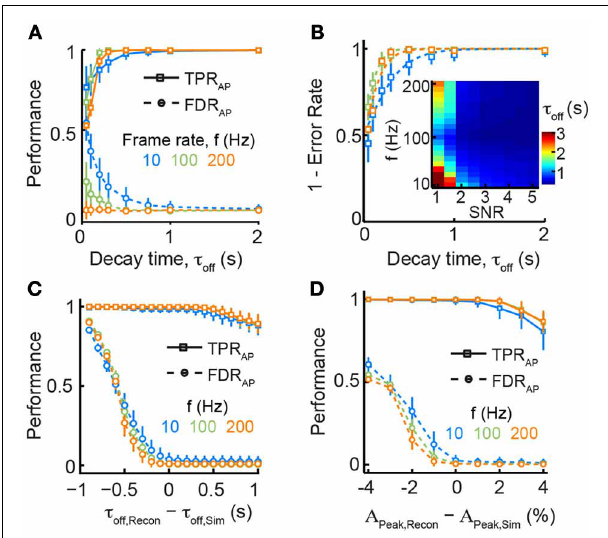
FIGURE 3 | Dependence of spike train reconstruction on assumed calcium transient parameters. (A) TPR AP (solid lines) and FDR AP (dotted lines) as function of decay time τ Off and frame rate f for fixed SNR = 3. Note that faster decay times lead to markedly reduced reconstruction performance especially at slow sampling rates. (B) Overall performance accuracy (1 − α AP ) increases for longer decay times. Dashed lines are logistic fits to the data points. The fits were used to compute the minimal decay time that would be necessary to reach an error rate α AP = 0 . 05 (inset). (C) Robustness of reconstruction performance against deviations from model parameters: decay time, τ = 1s and reconstruction was τ Off . Data were simulated with Off , Sim performed assuming different values for τ Off , Recon . Note that reconstruction with faster decay times leads to a strong increase in FDR AP whereas slower decay times lead to a more graceful deterioration of TPR AP ( SNR = 3). (D) Robustness of reconstruction performance against deviations from model parameters: peak calcium amplitude, A Peak . Data were simulated with A Peak , Sim = 7% (cid:2) F/F and reconstruction was performed assuming different values for A Peak , Recon . Reconstruction with smaller A Peak results in many more falsely detected APs whereas over-estimation of A Peak leads to a more graceful deterioration of TPR AP ( SNR =